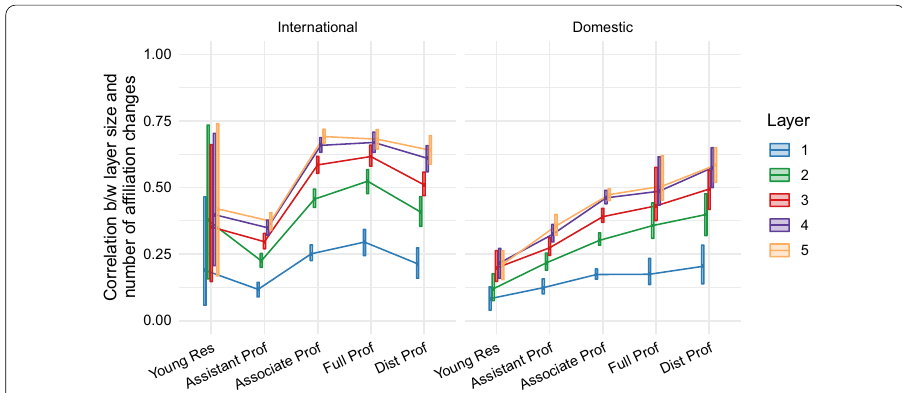
Fig. 12 Mobility profile and co-authorship ego networks for international and domestic migrants. Pearson correlation between ego network layer size and number of institutions changed at the different career